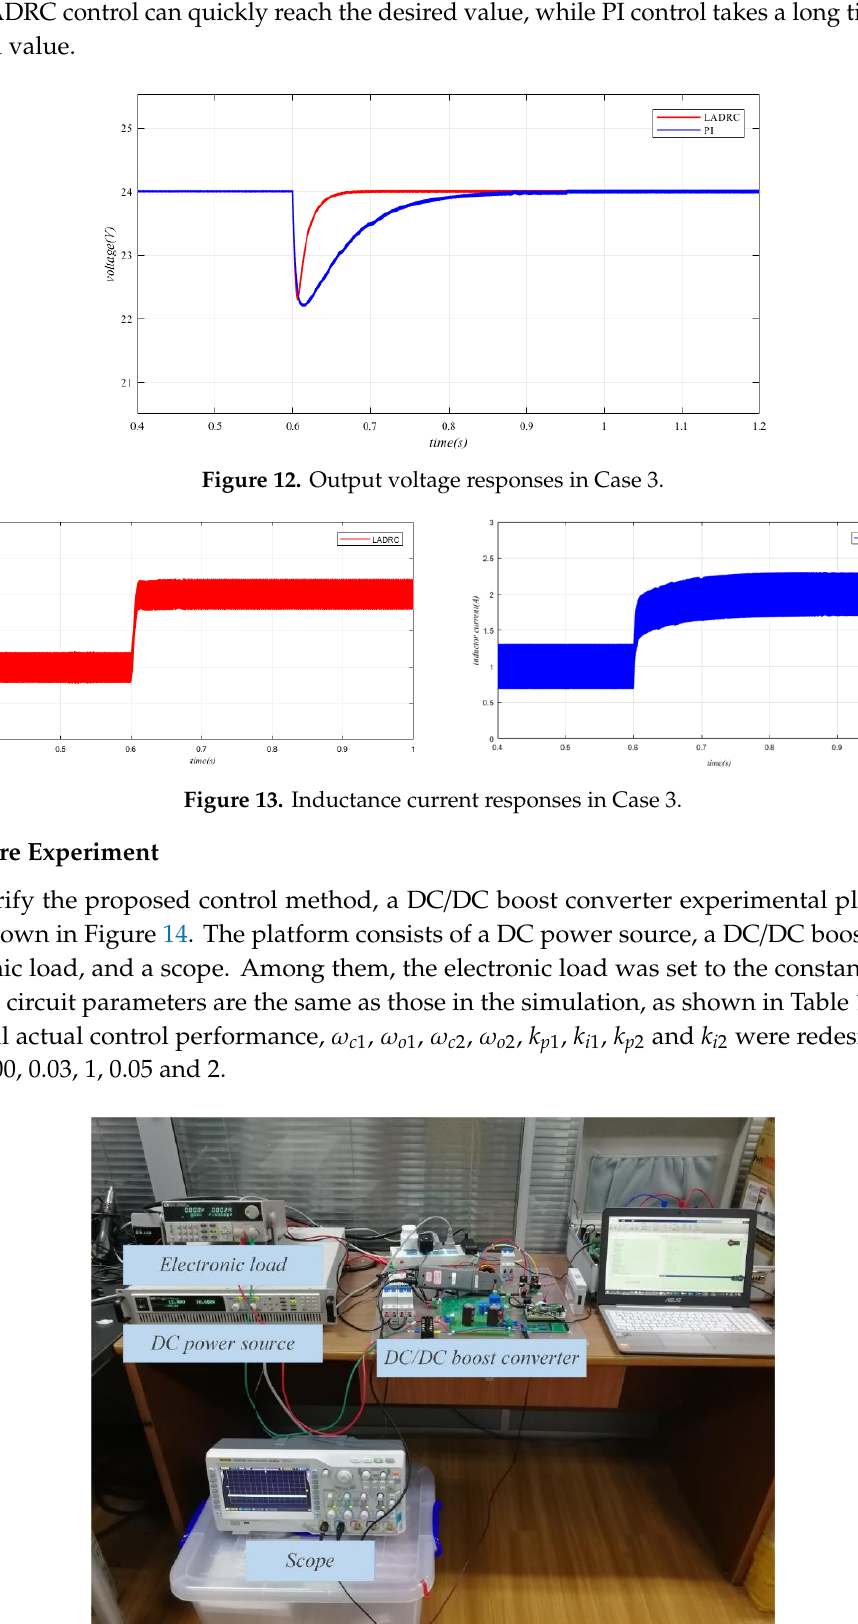
( b ) Figure 15. ( a ) LADRC controller: experimental comparison responses with Case 1; and ( b ) PI controller: experimental comparison responses with Case 1.